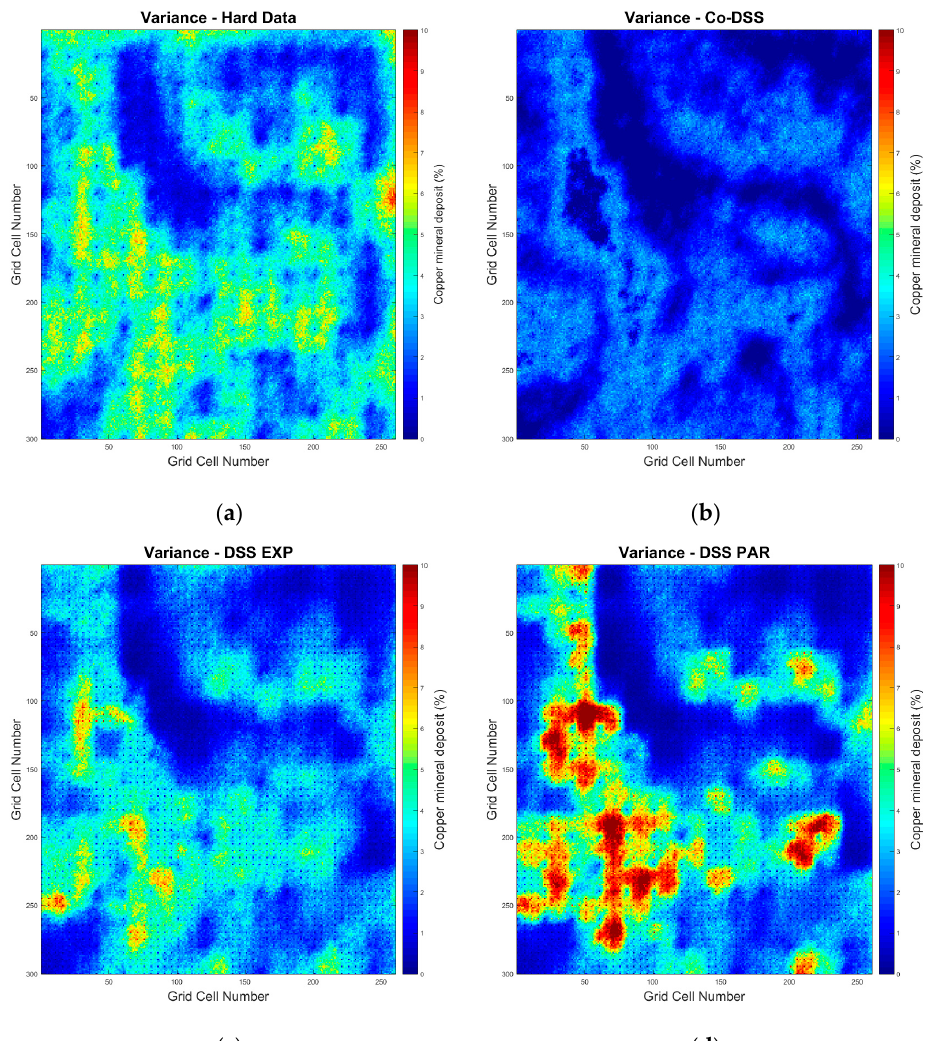
Figure 5. Variance of the 100 simulations for each simulation strategy used: ( a ) direct sequential simulation with only hard data, ( b ) direct sequential collocated co-simulation, ( c ) direct sequential simulation with experimental point distributions, and ( d ) direct sequential simulation with parameterized point distributions.